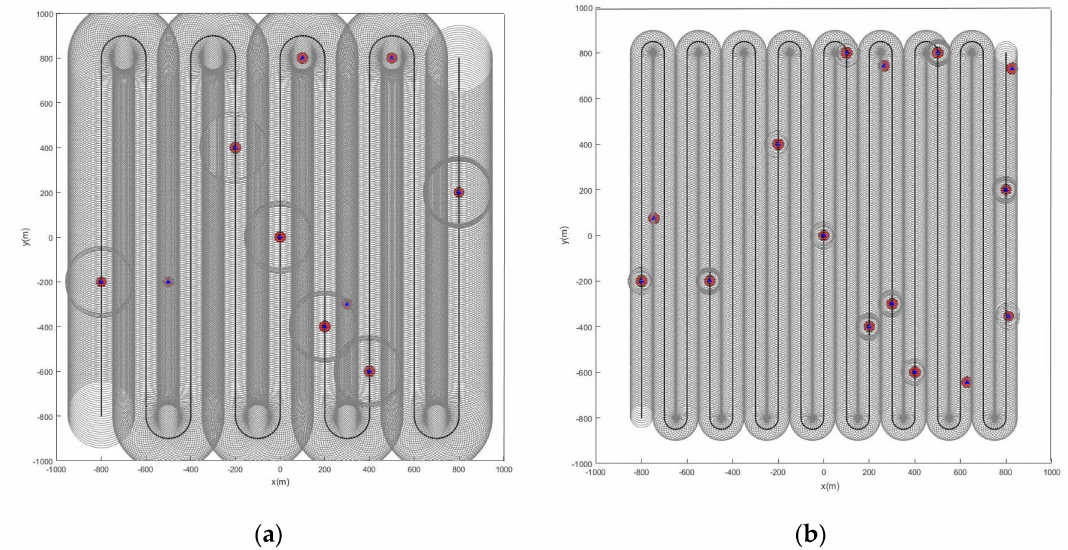
Figure 6. Estimated position of stationary feature points using the LMB algorithm (the red and blue marks indicate the true and estimated positions, respectively, of the feature points in the scene): ( a ) the detection radius of the sensor is 150 m, there are 10 feature points in the scene; ( b ) sensor detection radius is 50 m, there are 15 feature points in the scene.